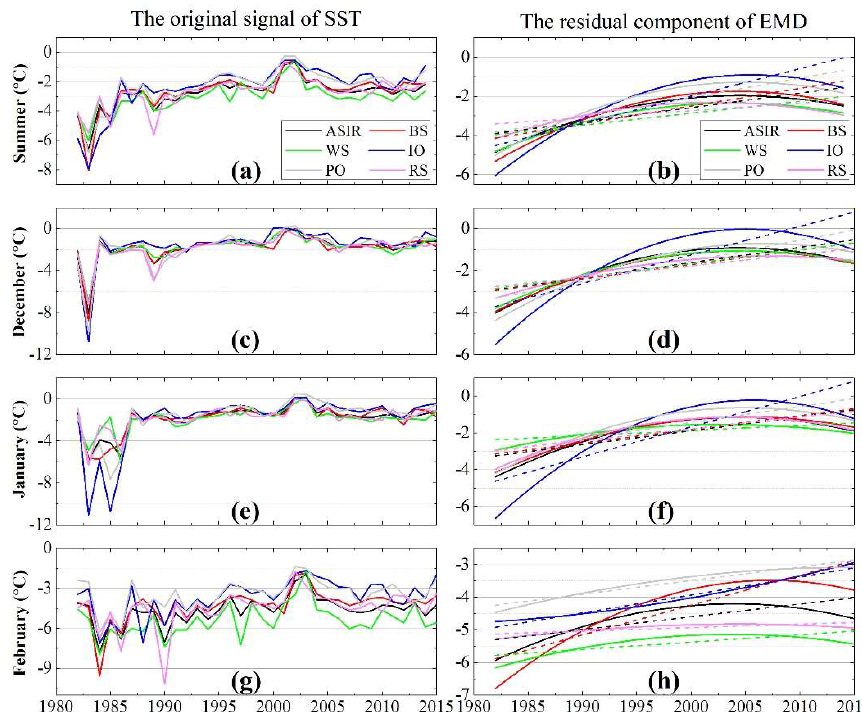
Figure 5. The same as Figure 3 but for SST (°C).